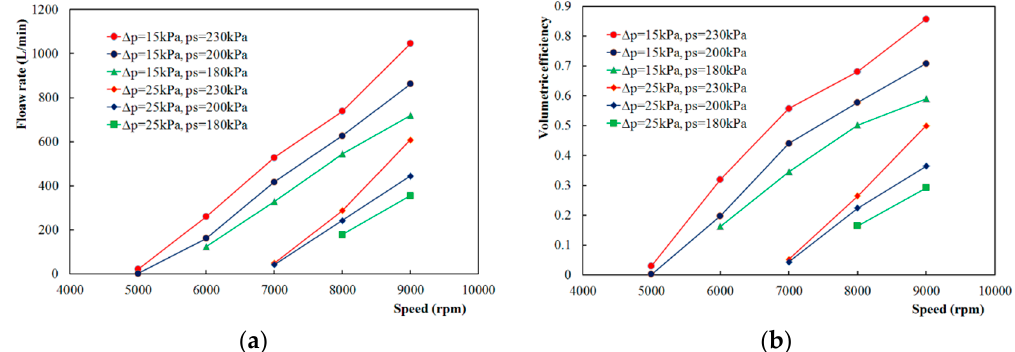
Figure 7. Effect of suction pressure on the performance: ( a ) flow rate; and ( b ) volumetric efficiency.